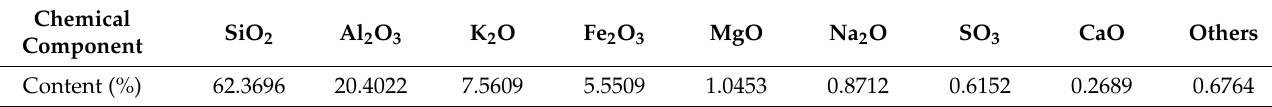
Figure 1. SEM results for the Yellow River Engineering Consulting (YREC): ( a ) the overall morphol- ogy; ( b ) multilayer platform structure; ( c ) flat structure. Table 2. Chemical composition from fluorescence spectrum